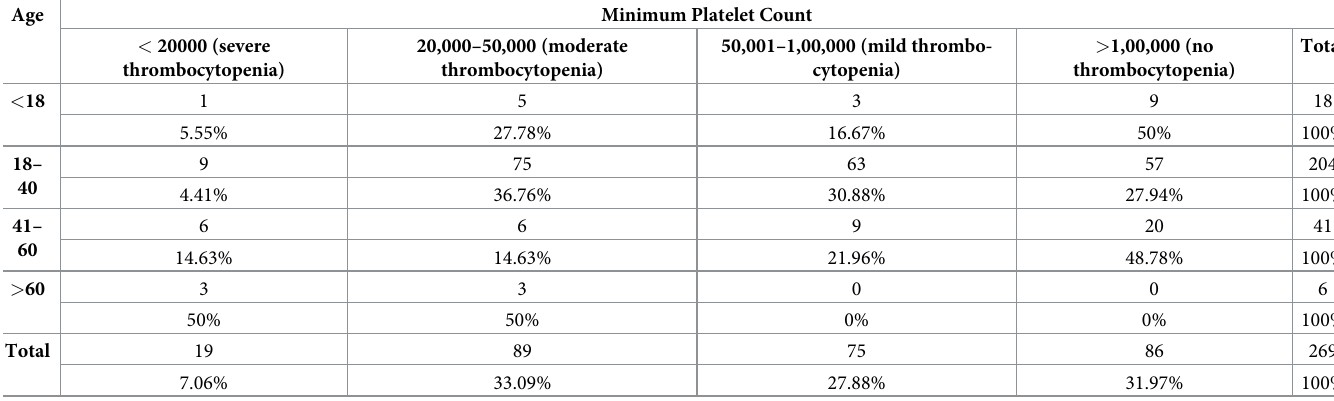
Table 1. Age wise distribution of severity of